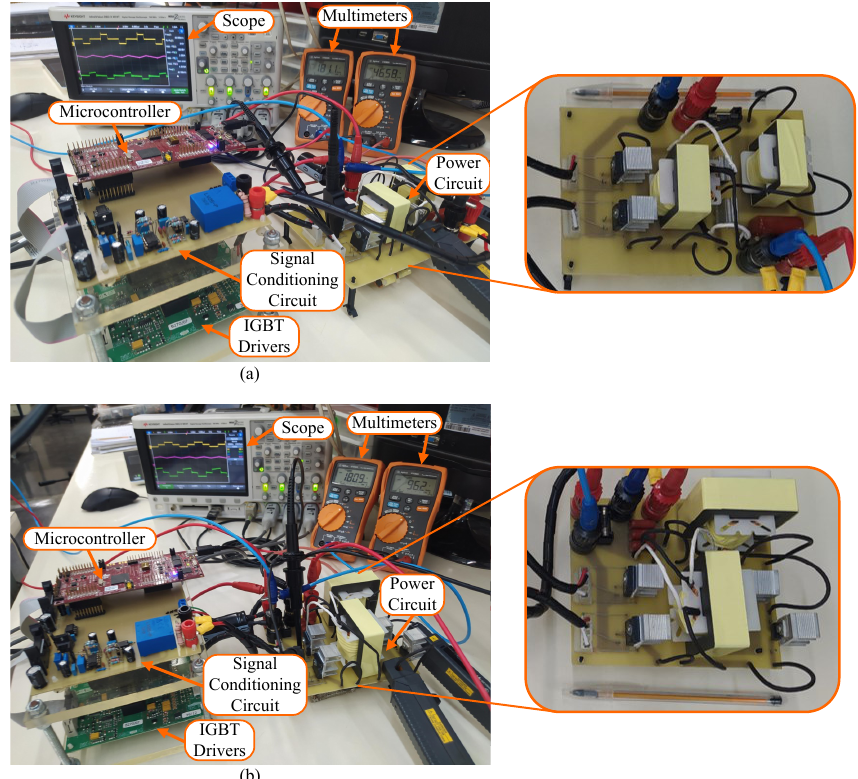
Figure 9. Experimental set-up of the 3SSC-A-based step-down converters: ( a ) 3SSC-A-based buck; ( b ) 3SSC-A-based buck-boost.